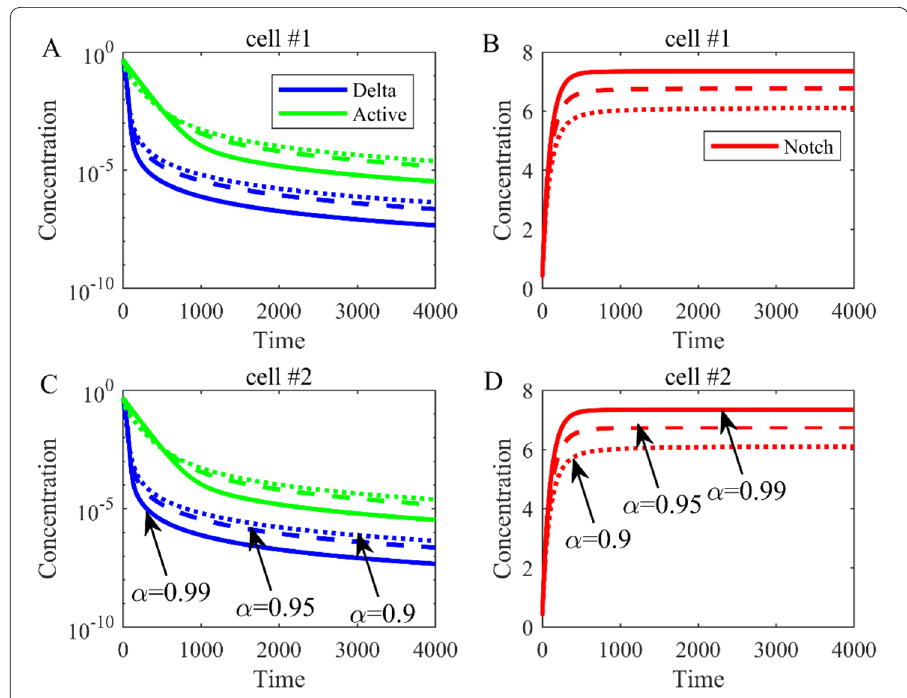
Figure 3 The dynamical trend of Delta, Notch, and active Notch when there is no expression of Delta ( λ = 0). ( A ) The dynamical trend of Delta and active Notch in cell 1. ( B ) The dynamical trend of Notch in cell 1. ( C ) The dynamical trend of Delta and active Notch in cell 2. ( D ) The dynamical trend of Notch in cell 2